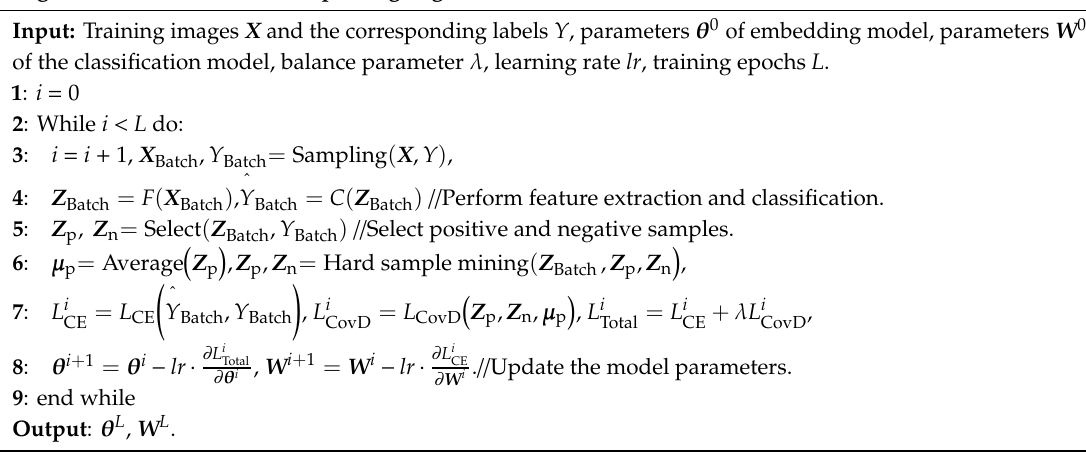
Algorithm 1. The Parameter Updating